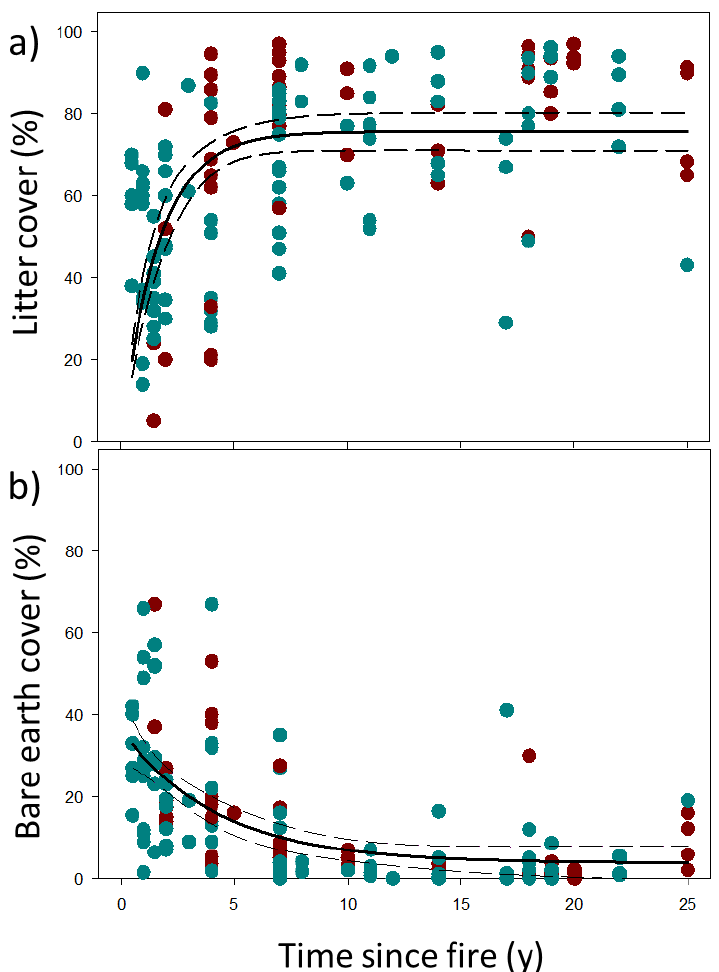
Figure 6. Litter cover increased ( a ) and bare earth decreased ( b ) nonlinearly after fire. No interactions were found between threatened ecological community type and time since fire. Symbols are the same as in Figure 5.